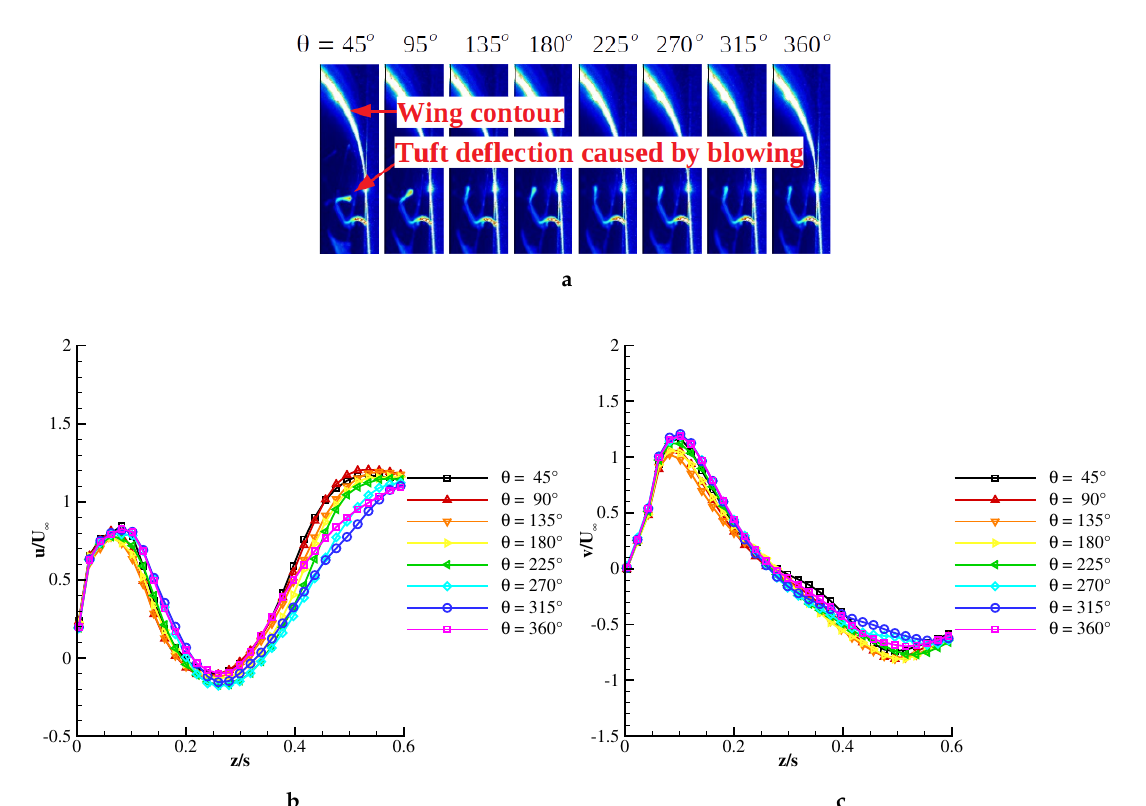
Figure 15. Phase averaged vertical velocity profiles across the forced vortex core at α = 35 ◦ , x / c r = 0.65, and y / s = 0.36. ( a ) Phase definition; ( b ) axial velocity; ( c ) spanwise